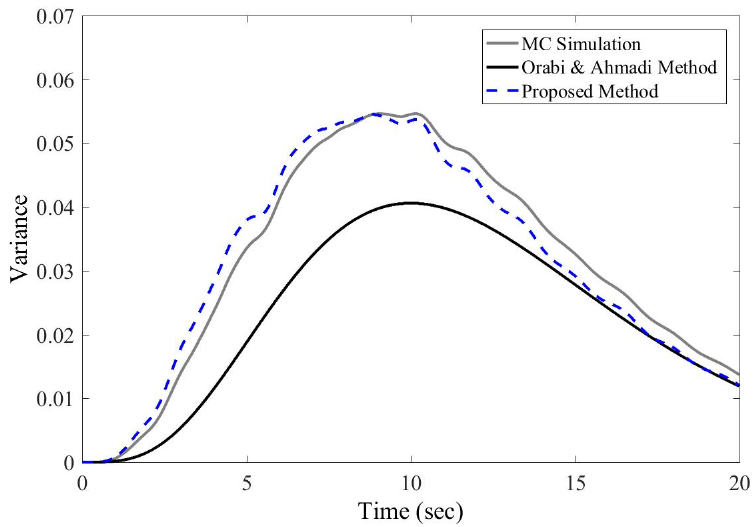
Figure 7. Mean square displacement response due to nonstationary excitation. ( γ = 1.0, μ = 10.0).